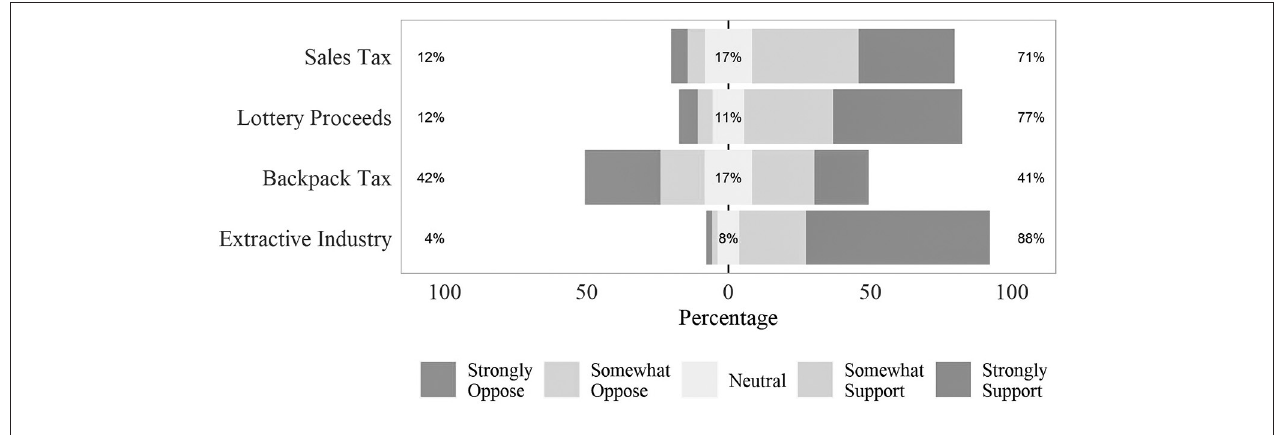
FIGURE 1 | Support for conservation funding policies